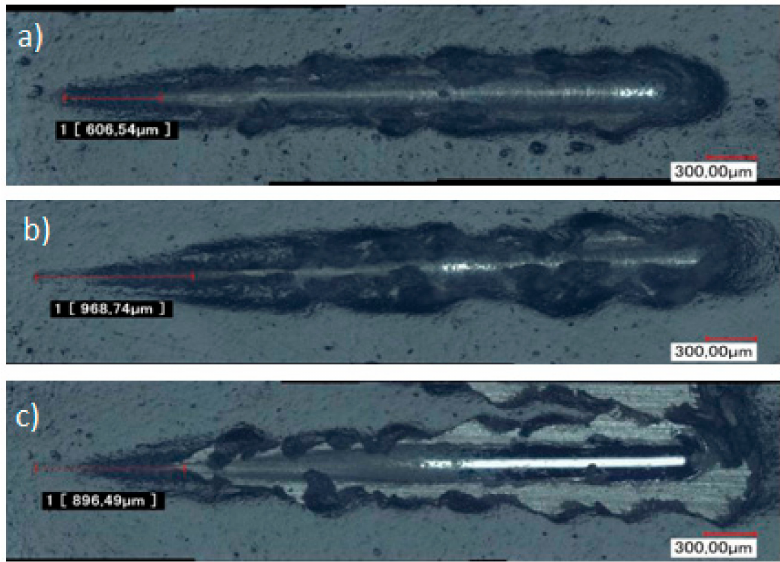
Figure 7. Optical micrographs of microscratch strip on ( a ) phosphated zinc + paint; ( b ) phosphated zinc + TEOS/MAP + paint; and ( c ) phosphated zinc + GPTMS/ASB + paint.